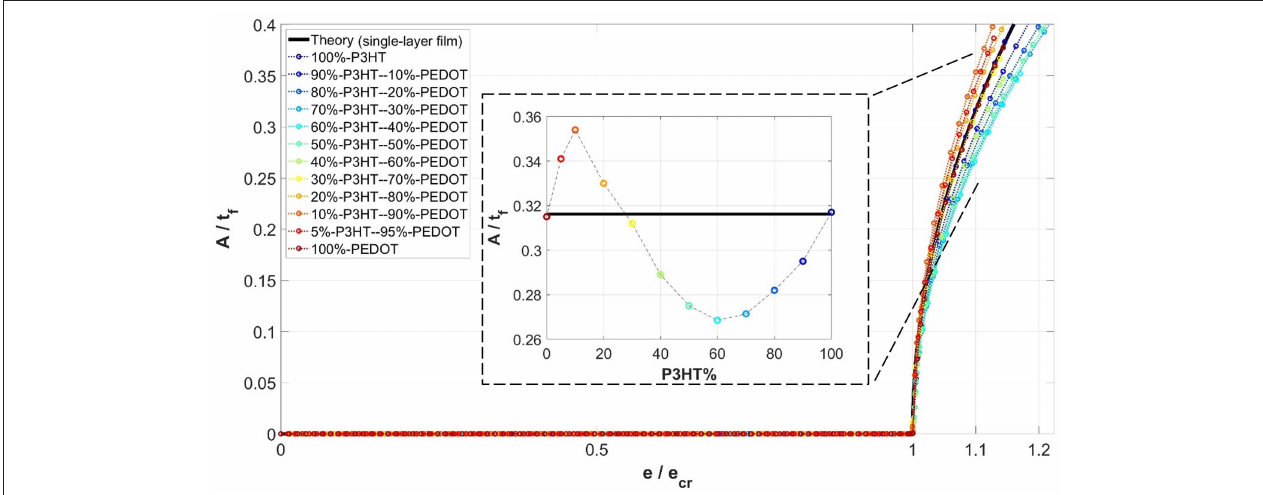
FIGURE 7 | Variations of simulated wrinkling amplitude, normalized by total thickness of the film ( A / t f ), with the progression of normalized applied compressive strain ( e e ), for different fractional volume percentages of the composite films, for the case of generalized plane strain (GPE) under direct compression. Note that the cr = 1.10. amplitudes shown in the inset pertain to e e cr